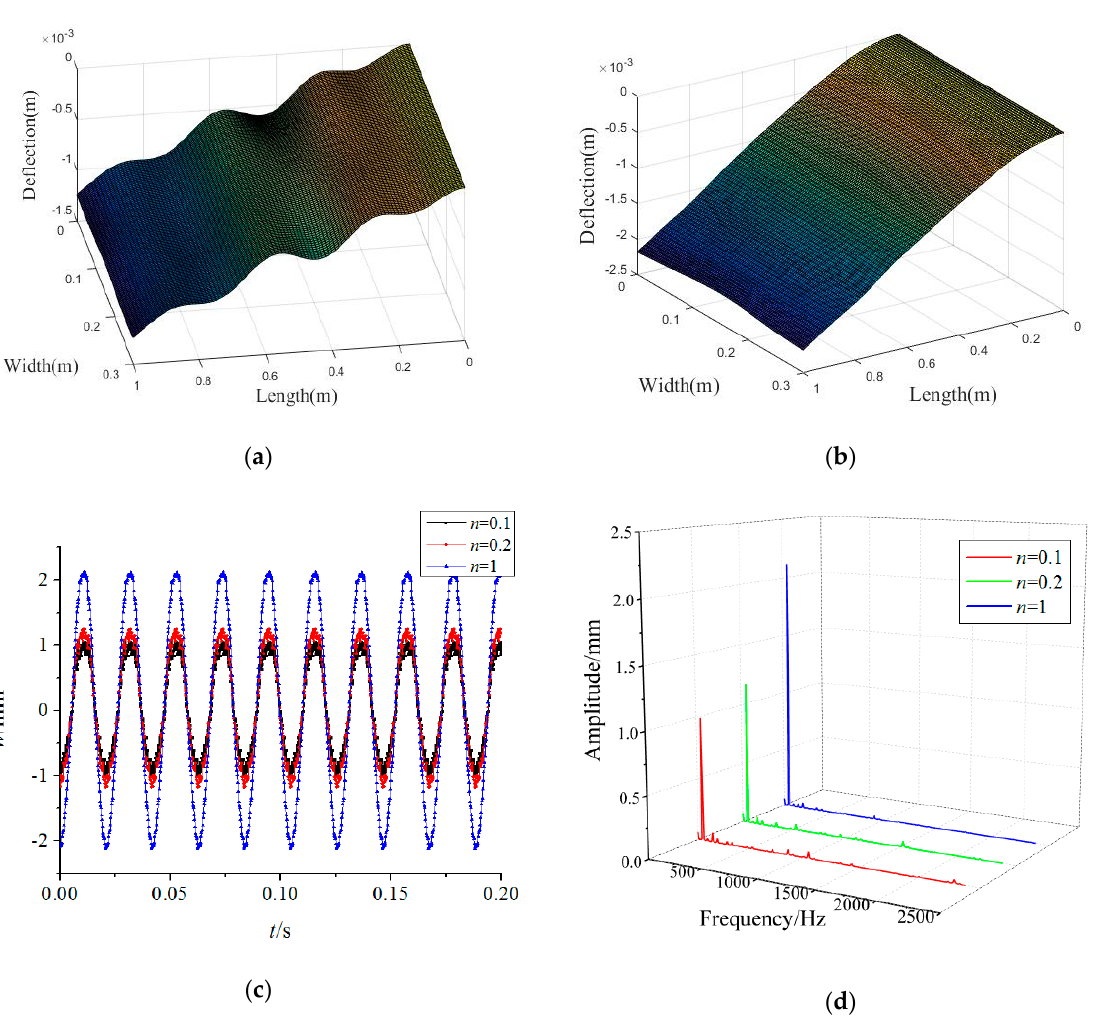
Figure 4. Effects of power-law indices on forced vibration responses of the rotating FGM plate ( a ) n = 0.2, ( b ) n = 1, ( c ) time-domain response, ( d ) frequency-domain response.